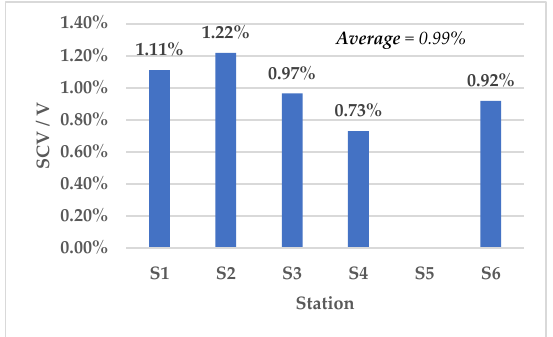
Figure 8. Ratio of SCV (m 3 ) to V (m 3 ) per station.